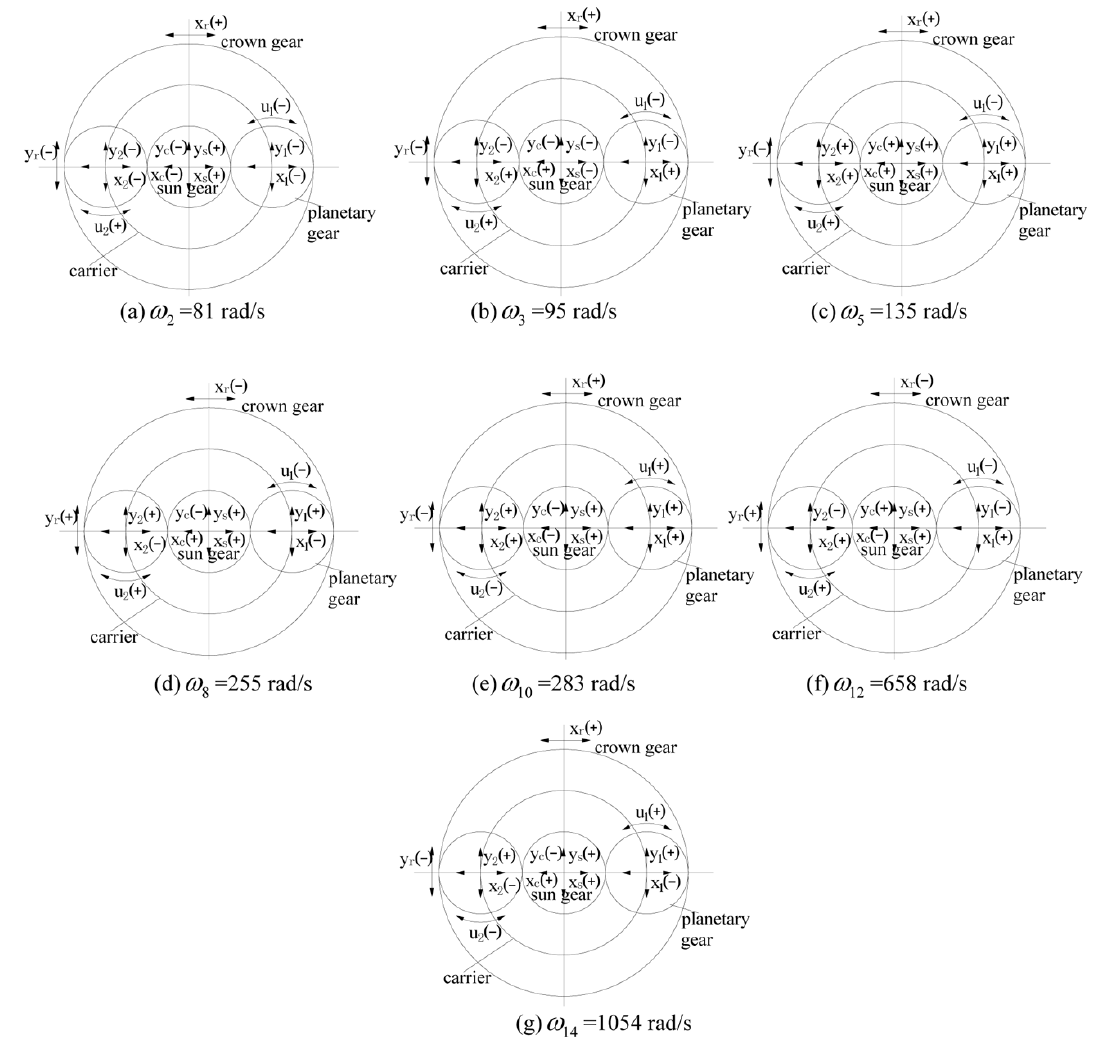
Fig. 8. Translation modes of the central elements ( N = 2).